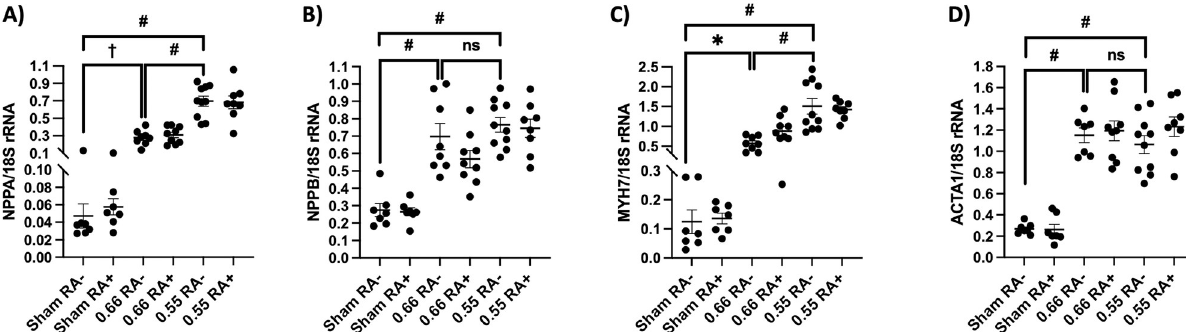
Fig 6. Foetal gene activation in HF with or without arthritis. Myocardial gene expression levels of NPPA (panel A), NPPB (panel B), MYH7 (panel C) and ACTA1 (panel D) was analysed at termination of the experimental study, relative to the housekeeping gene 18S (n = 7, 7, 8, 9, 10, 8 for sham RA-, sham RA+, ORAB 0.66 RA-, ORAB 0.66 RA+, ORAB 0.55 RA- and ORAB 0.55 RA+, respectively). One outlier was excluded in the analysis of ACTA1 in the 0,66 RA- group. Data is displayed as scatter plots with mean ± SEM. Statistical significance was calculated using one-way ANOVA with Bonferroni’s multiple comparisons test. ns = non-significant, � P < 0.05, † P < 0.01; ‡ P < 0.001, # P < 0.0001. NPPA , natriuretic peptide A; NPPB , natriuretic peptide B; MYH7 , myosin heavy chain 7; ACTA1 , actin alpha 1, skeletal muscle.